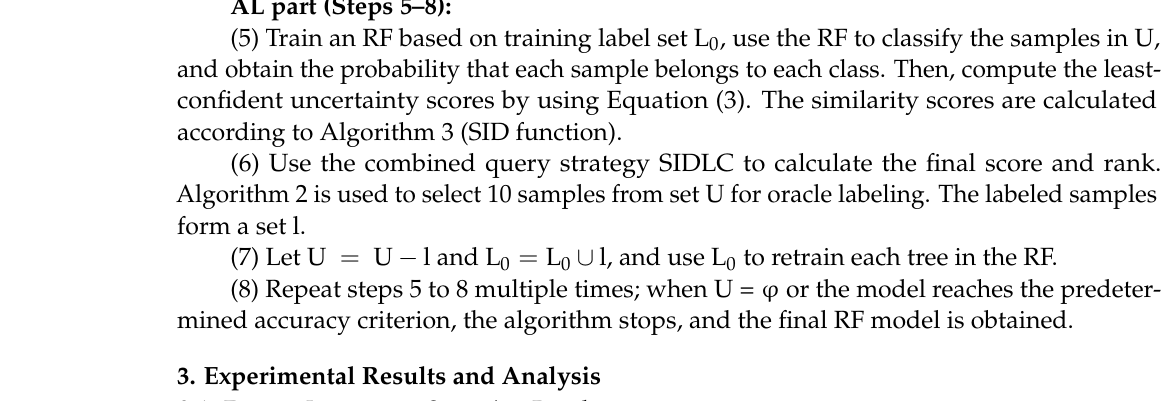
Table 4. Top 25 features.